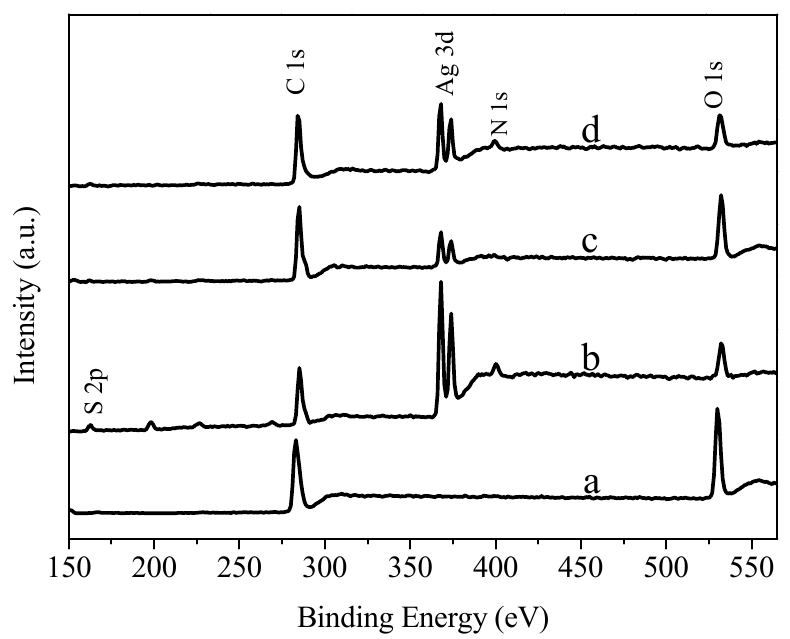
Figure 6. XPS (X-ray photoelectron spectroscopy) wide scans of ( a ) GO, ( b ) NH2-AgNWs, ( c ) AgNWs/GO-2 and (d) AgNWs/GNs-2.